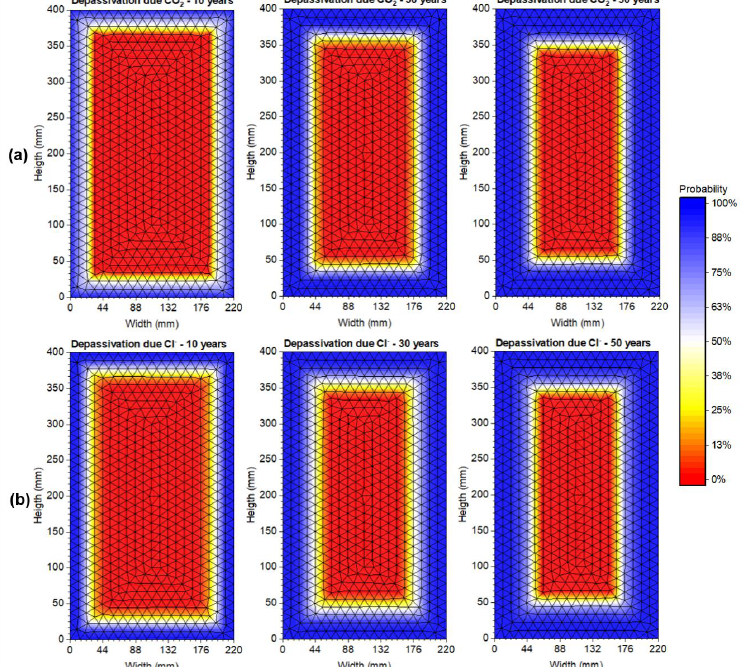
Figure 12. Depassivation probability in function of concrete cover and structure age for a concrete beam located in ( a ) São Paulo — considering carbonation process and ( b ) Florianópolis — considering chloride diffusion.